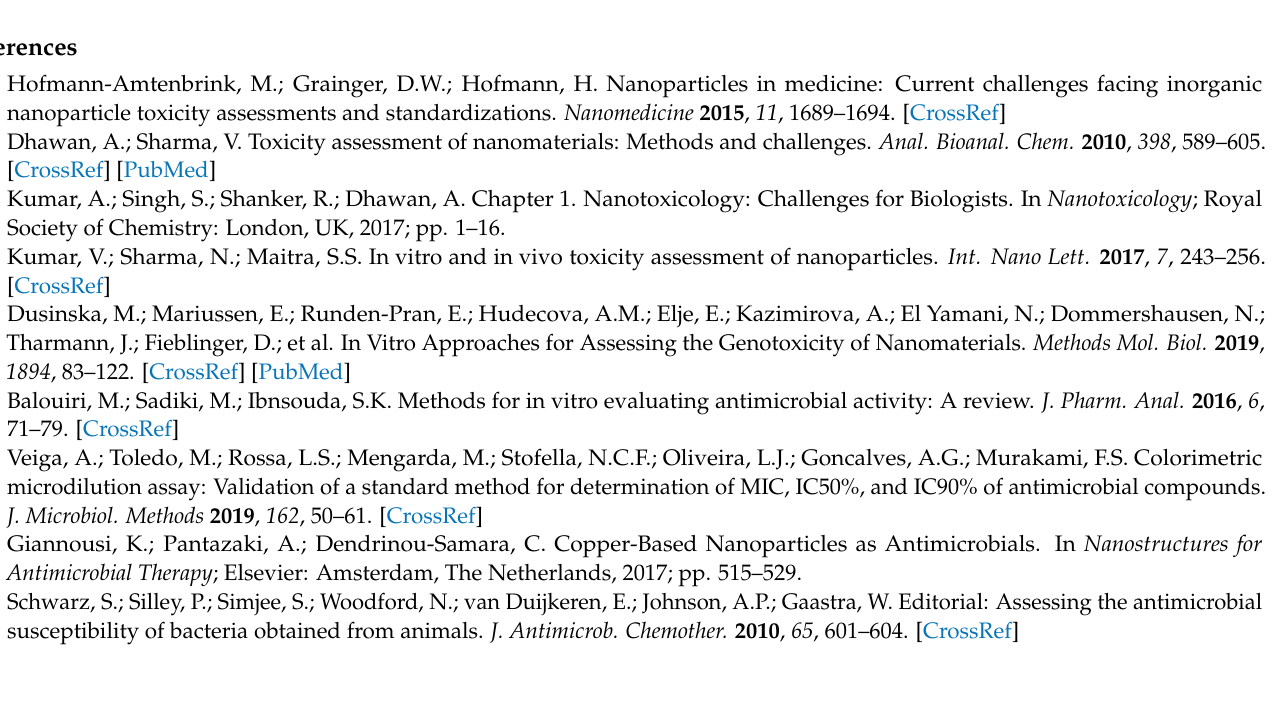
analysis of the bacterial growth averages obtained from LUX490 (8 h) and OD600 (24 h), for all inhibitory concentrations of SPION@MNs systems against E. coli Lux and E. coli , respectively; Figure S1: pMV306G13 + Lux plasmid constitution; Figure S2: Plates with the dilutions 10 − 4 (TSA Lux3), 10 − 5 (TSA Lux4) and 10 − 6 CFU (TSA Lux5) for CFU counting of luminescent E. coli Lux suspension; Figure S3: The susceptibility of the wild-type parent E. coli (ATCC®8739TM) to ofloxacin, given as raw OD600 vs. concentration of OFLO; Figure S4: E. coli Lux growth data under shaking (a,b) and static (d,e) conditions; Figure S5: Absorbance spectra of MNs and SPION@MNs, in water; Figure S6: Structural representation of all model drugs and respective absorbance spectra: epirubicin (EPI), doxorubicin (DOX) and ofloxacin (OFLO); Figure S7: Antimicrobial activity of single and combinatory drug controls on the parental E. coli strain; Figure S8: Statistical comparison of the obtained relative growth reduction; Figure S9: Statistical comparison of the MIC50/MIC90 obtained, via LUX490 8 h-assaying of E. coli Lux, for trial 1 (t1) and trial 2 (t2), of all OFLO-containing drug